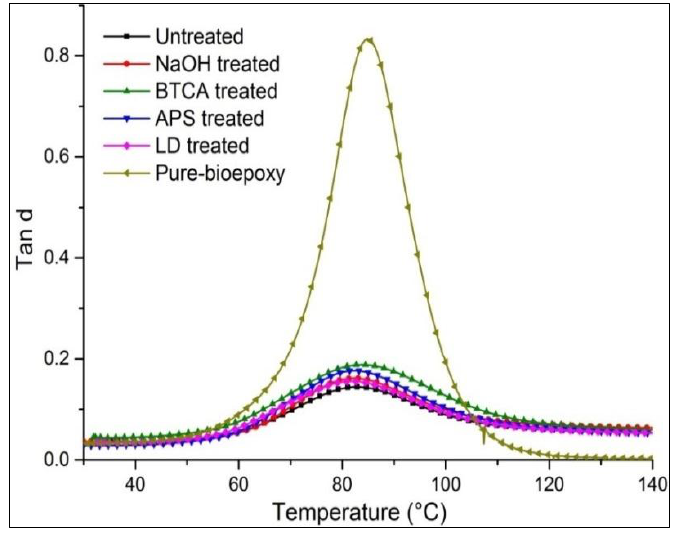
Figure 4. Representation of tanδ of resin and FE composites with